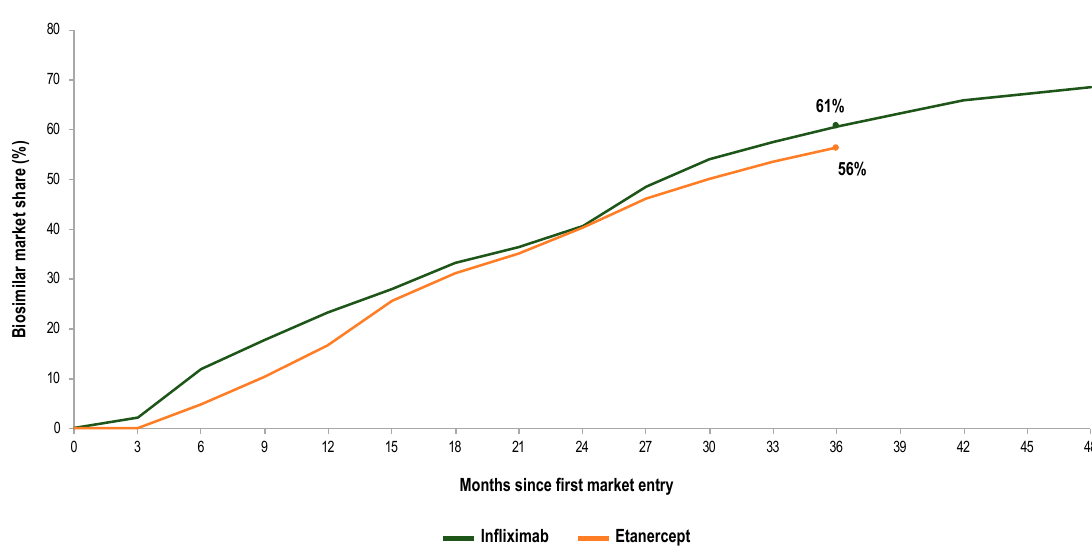
Figure 4. Biosimilar penetration for infliximab and etanercept in Germany over time. Biosimilar market shares (%) are calculated as volume of biosimilars over volume of biosimilars plus the originator product (DDDs). Table 1. Market shares (%) of biosimilar infliximab and etanercept in Germany’s 17 PA regions. Colors gradually change from red to green with increasing biosimilar market shares.